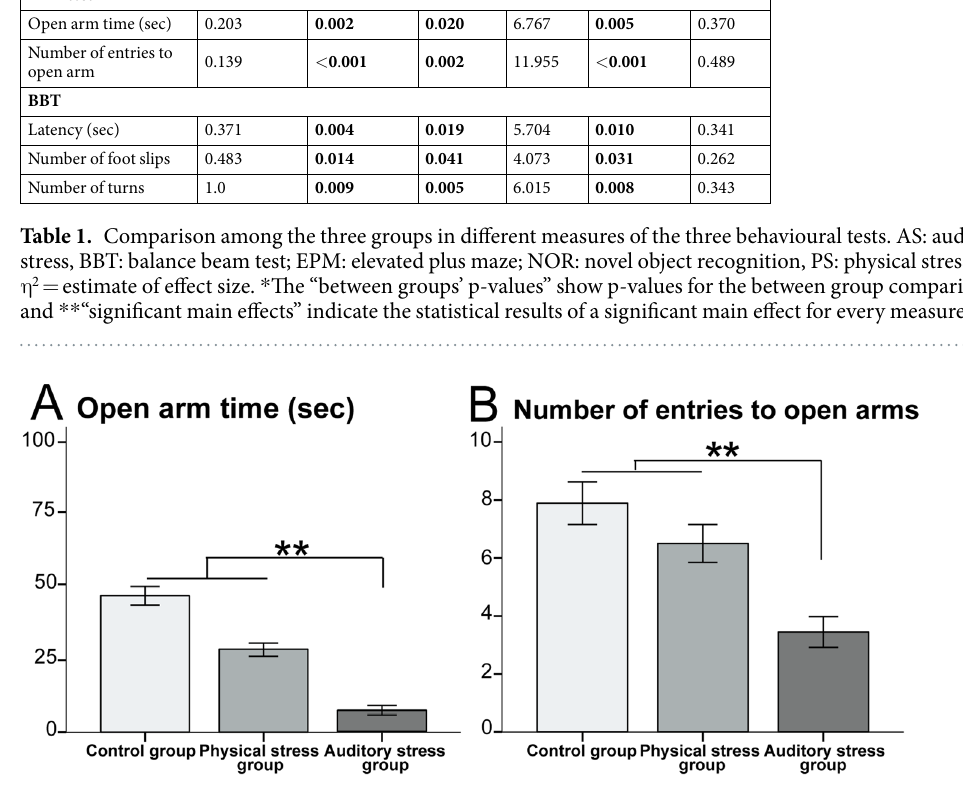
Figure 2. The elevated plus maze (EPM) test: The auditory stress group indicated ( A ) shorter time in open arms (sec), and ( B ) lower number of entries to open arm compared with the two other groups. N = 10 in all groups. Results are reported as mean ± S.E.M. Asterisks indicate * p <